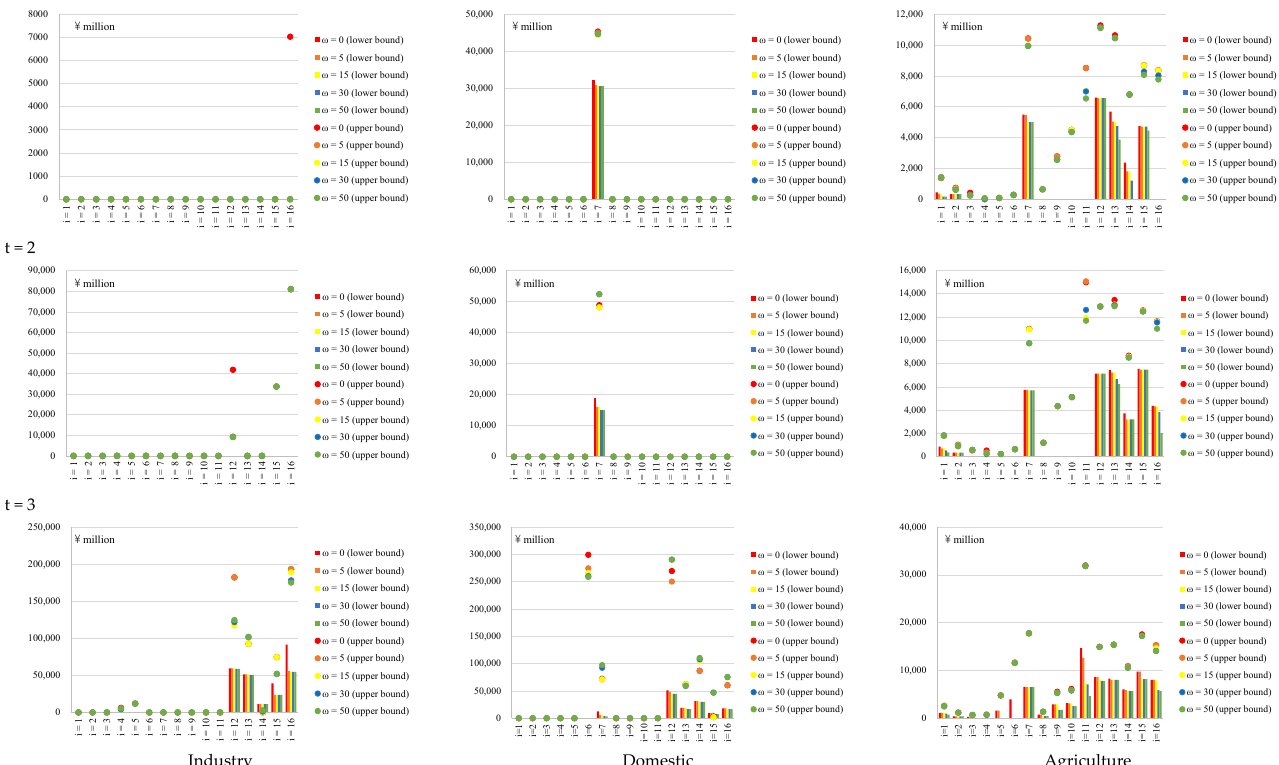
Figure 3. Downside risks in the Fenhe River Basin at different risk levels.